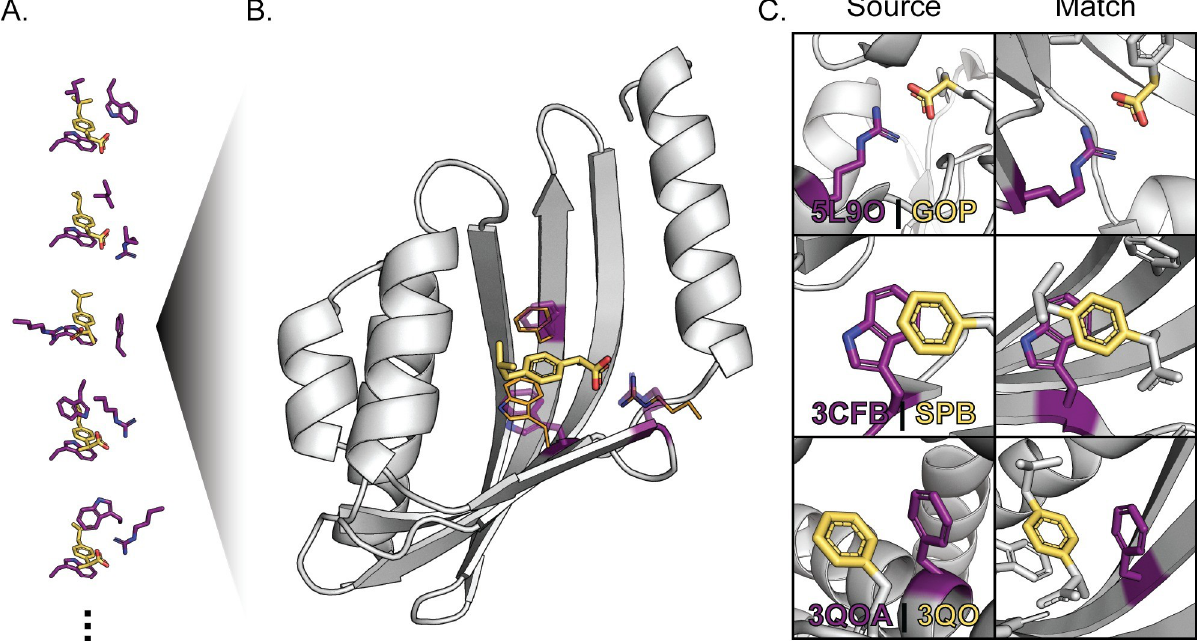
Fig 3. Discrete Protein-Fragment Contacts are Assembled into Composite Binding Sites. A. Composite binding sites are generated by combining discrete, observed contacts (purple side chains) with fragments that compose the target ligand (yellow) into low-energy configurations using a simulated annealing protocol. B. RosettaMatch finds scaffold proteins (grey) with existing cavities that can accommodate the target ligand with close agreement with contact residue geometries defined in composite binding site solutions (RosettaMatch residues: purple sticks, composite binding site definition: orange lines). C. Comparison of protein residue (purple) interactions with defined fragments (yellow) in the context of the protein-ligand complex that served as the source of a contact pool interaction (Source) and in the context of a match produced using RosettaMatch (Match). The source protein-ligand complex PDB ID and ligand chemical component identifier are provided for each source interaction.